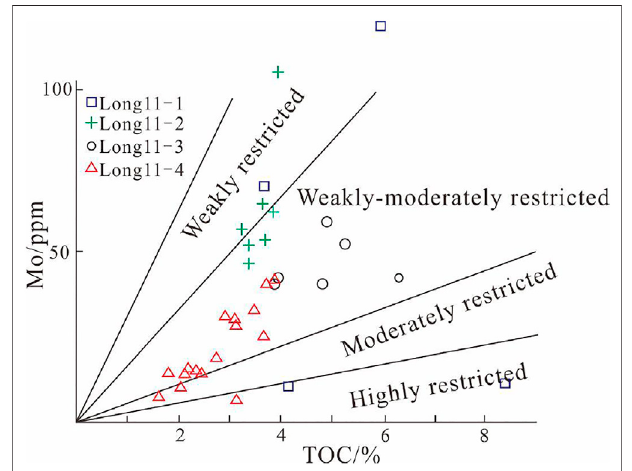
FIGURE 10 | Mo – TOC covariant diagram of the Longmaxi shale in the Changning area.